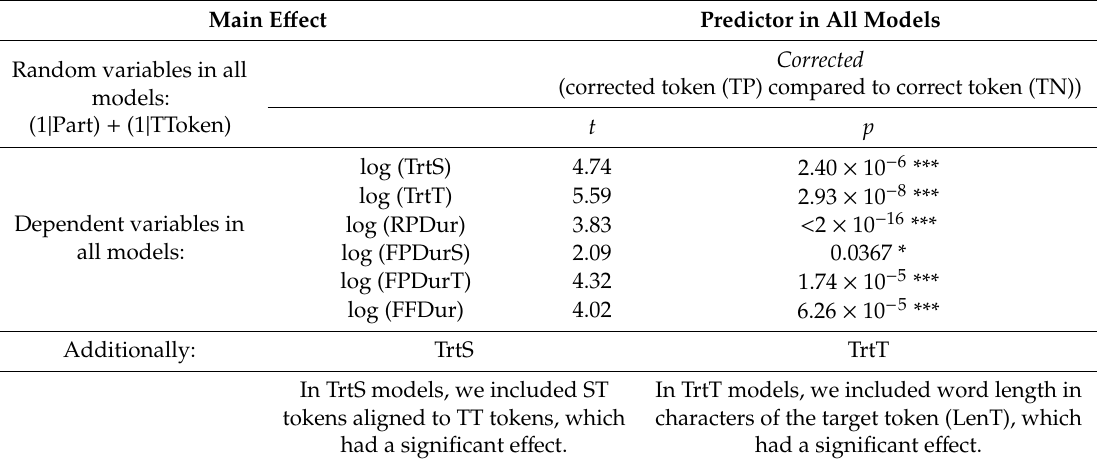
Table 5. T-values and significance intervals ( p ) for the main e ff ects of Corrected on the dependent variables. Main E ff ect Predictor in All Models